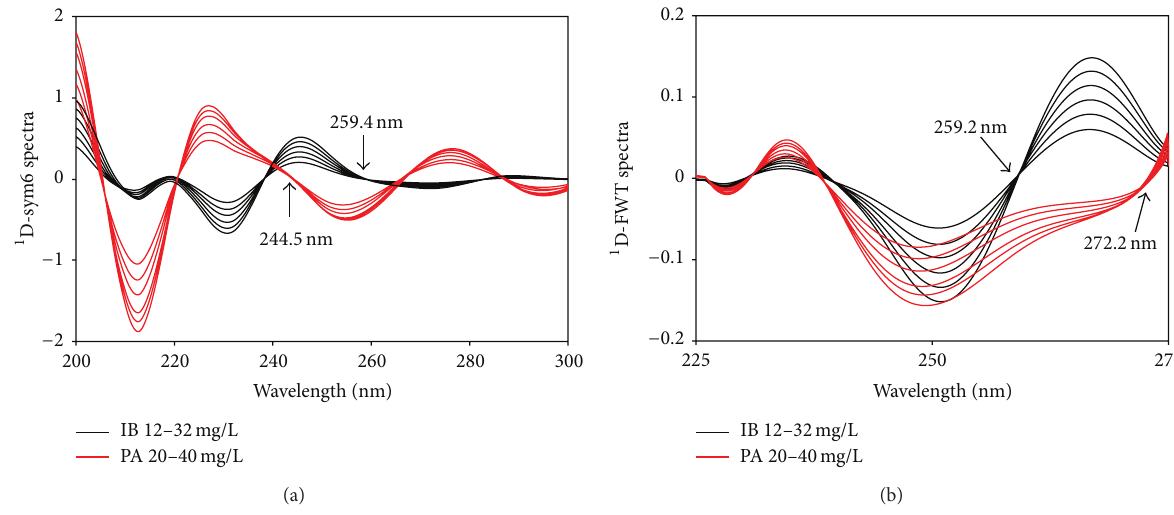
Figure 9: Derivative transform of wavelet transformed spectra by sym6 (a) and FWT (b).